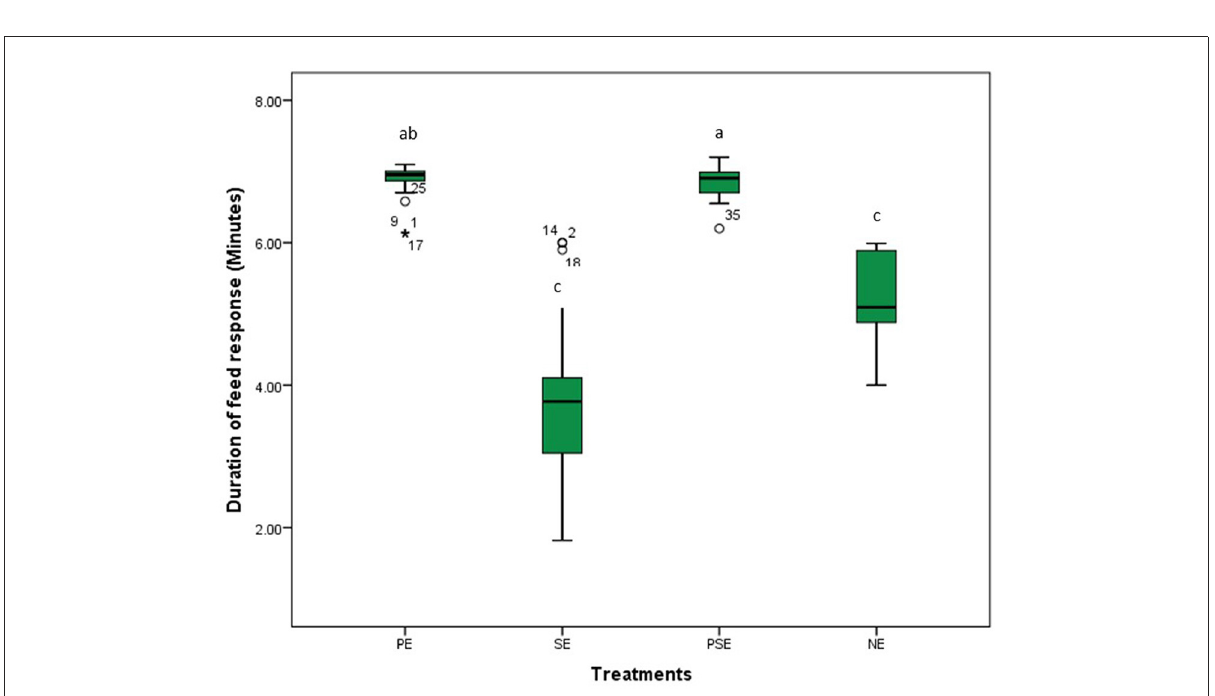
FIGURE3 The effect of environmental enrichments on the feed response of juveniles of Clarias gariepinus under laboratory conditions. abcd Means of the duration of feed response differ ( p < 0.05) between treatments.